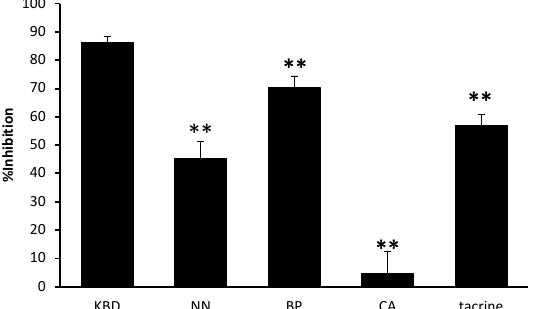
Figure 2. The effect of the KBD and its components on AChE activity. The KBD extract 3 mg/mL (KBD) and its components at equivalent amount, i.e., Nelumbo nucifera 1 mg/mL , (NN), Piper nigrum 1 mg/mL (BP), and Centella asiatica 1 mg/mL (CA) were evaluated for AChE inhibitory action by Ellman’s assay. Data are reported as means ± SD ( n = 3). ** p < 0.01 as compared with the KBD group. Tacrine 0.30 µM was used as a positive control.